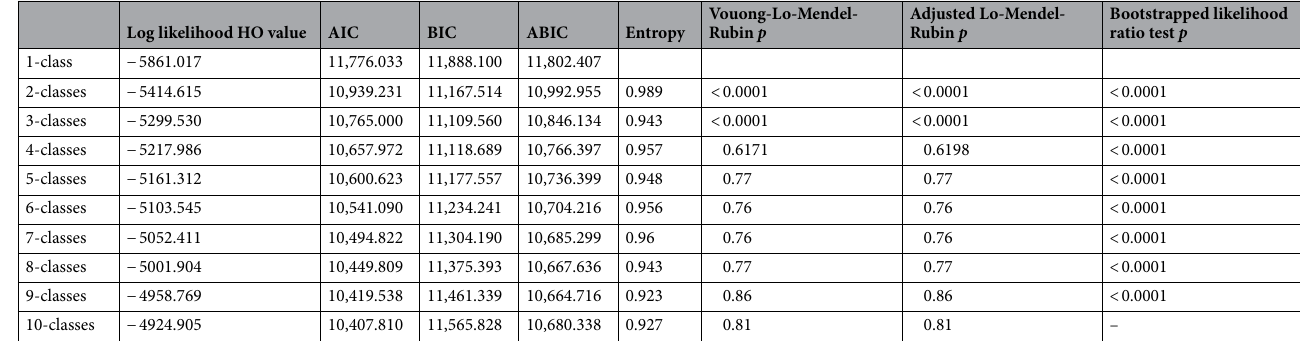
Table 4. LCA models’ fit. AIC Akaike Information Criterion, BIC Bayesian Information Criterion, ABIC adjusted Bayesian Information